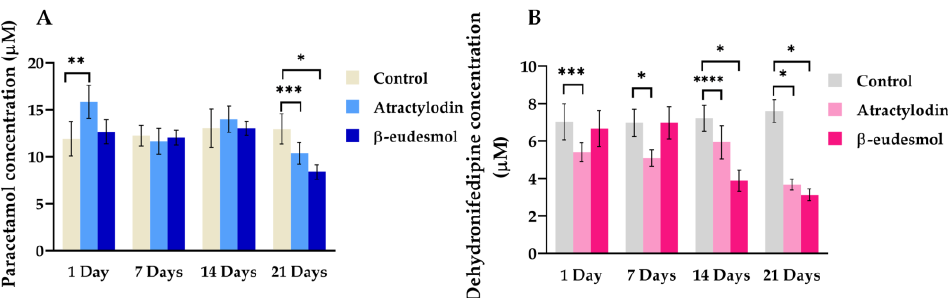
Figure 3. The mCYP1A2-and mCYP3A11-mediated metabolites in mouse liver microsomes. mCYP1A2 ( A ) and mCYP3A11 ( B ) enzyme activities were determined in the liver microsomes of male ICR mice following a daily oral dose of 100 mg/kg body weight of atractylodin or β -eudesmol for 1, 7, 14, and 21 days. Control mice were fed with distilled water. Data are expressed as median (95% CI) from three experiments (duplicate each). Asterisks indicate a significant difference with control. Statistical significance with * p = 0.004, ** p = 0.006, *** p = 0.010, **** p = 0.016 compared with control.